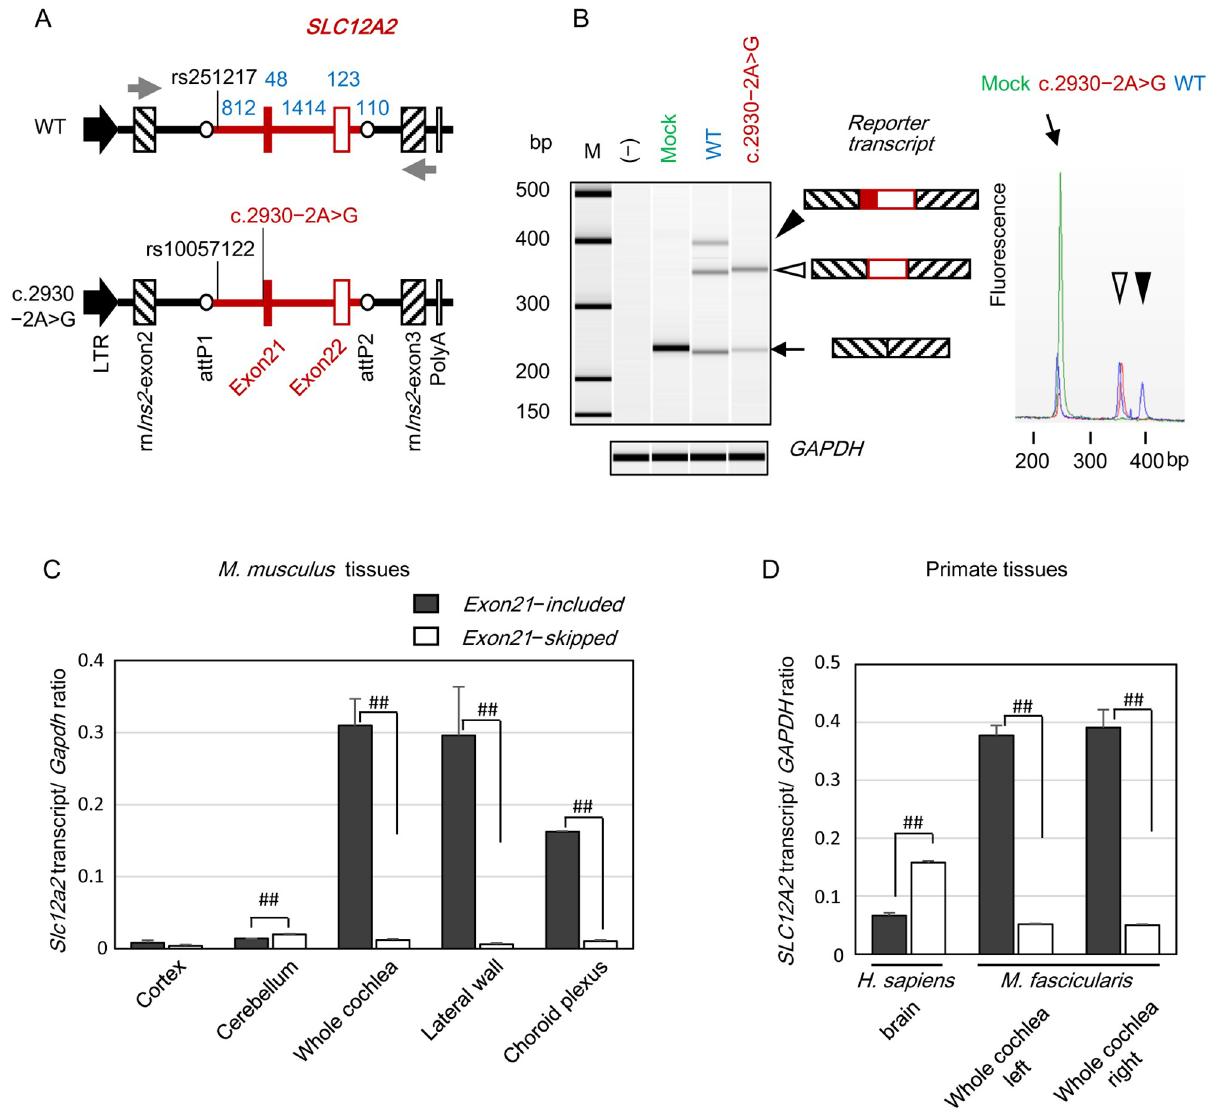
Fig 3. Splicing analysis of SLC12A2 exon 21 and expression levels of SLC12A2 transcripts in mammalian tissues. (A) Minigene structures. Rous sarcoma virus long terminal repeat (LTR, black arrows), rat insulin-2 ( rnIns2 , boxes with slashes), BP clonase site attP1/P2 (open circles), and partial genomic region of WT SLC12A2 or SLC12A2 with the splice-site mutation (c.2930–2A > G) (red line) including exons 21 (filled red box) and 22 (open red box) are shown. Numbers in blue indicate the nucleotide length (bp) of each SLC12A2 genomic region. Small gray arrows indicate positions of primer sets for RT-PCR (S8 Table). Positions of SNPs and the splicing variant of SLC12A2 are also indicated. (B) Left , RT-PCR (N = 3) to detect reporter transcripts in HEK293T cells transfected with the respective vectors. The image of the RT-PCR products was generated using a BioAnalyzer 2100. The size of each reporter transcript is indicated by an open or filled arrowhead, or small arrow. M, 100 bp ladder marker; (–), no transfection; mock, empty vector. Right , Partial electropherograms of reporter transcripts. Schematics of each transcript are indicated by arrowheads or small arrows. (C,D) Quantitative RT-PCR (qRT-PCR) to measure the expression levels of the Slc12a2 exon 21-included and -skipped transcripts in M . musculus tissues (N = 3) (C) and in human brain and whole cochlea from M . fascicularis (D). ##, p <